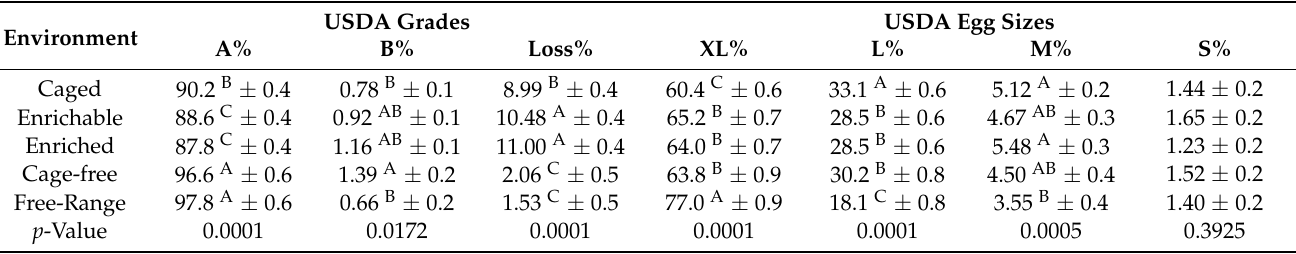
Table 5. The effect of housing system environment on USDA grades and sizes of brown layers.